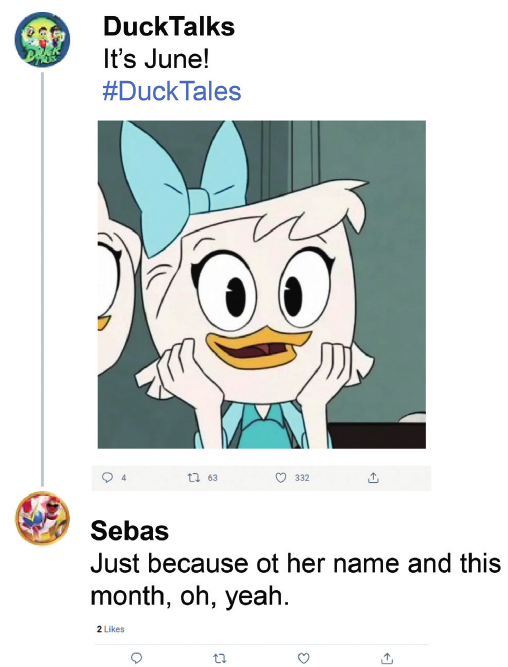
Figure 1: Some tweets related to a hashtag: